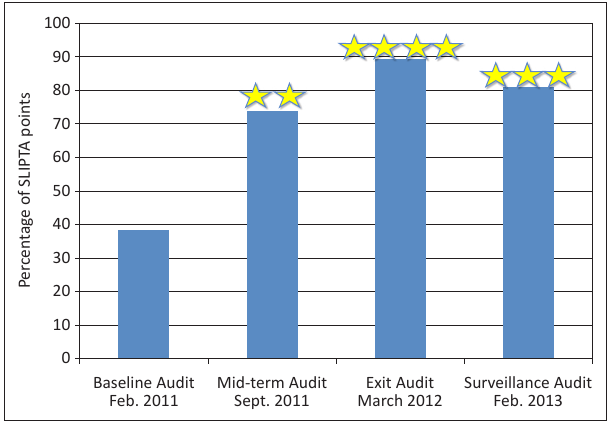
FIGURE 1: Results for baseline, mid-term, exit and surveillance audits, Bungoma District Hospital Laboratory,